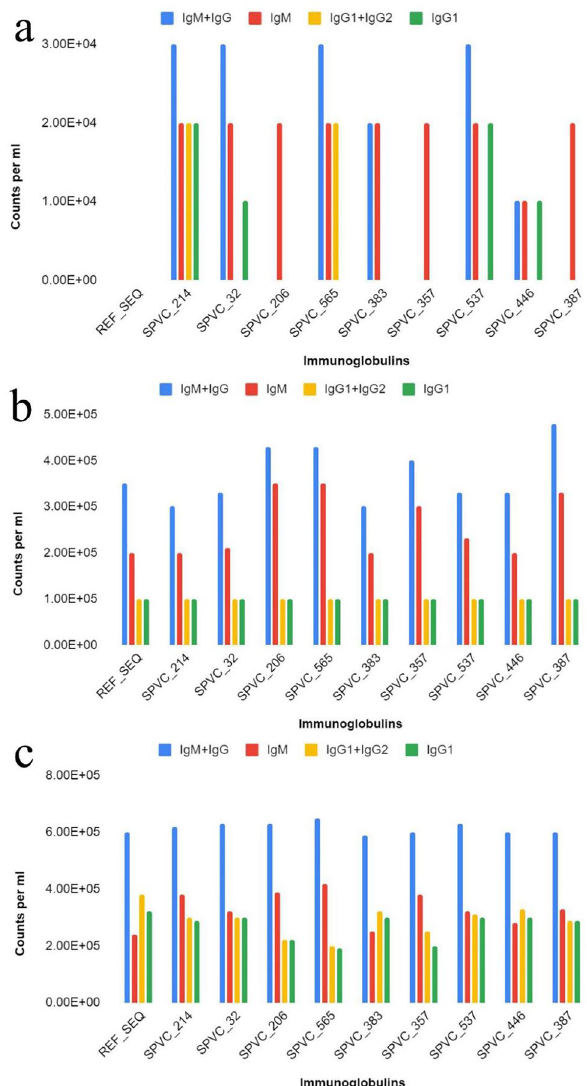
Figure 4. Immunoglobulin counts of MEBP variants (with adjuvants + HIS-tag) after ( a ) 1st dose, ( b ) 2nd dose, ( c ) 3rd dose (X axis—vaccine constructs, Y axis—counts per